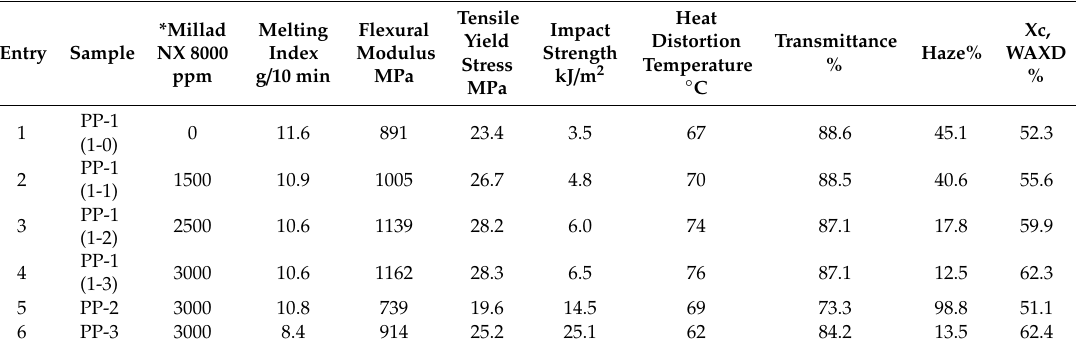
Table 2. Mechanical analysis results of the PP materials.